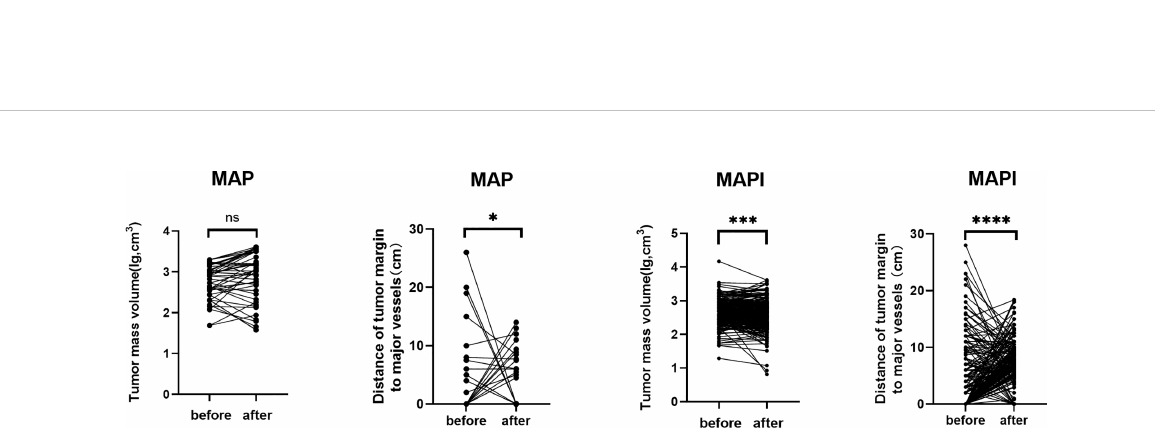
FIGURE 4 Statistical analysis of effects of IFO on the TMV and NBT after neoadjuvant chemotherapy. *p<0.05; ***p<0.001; ****p<0.0001; ns, no signi fi